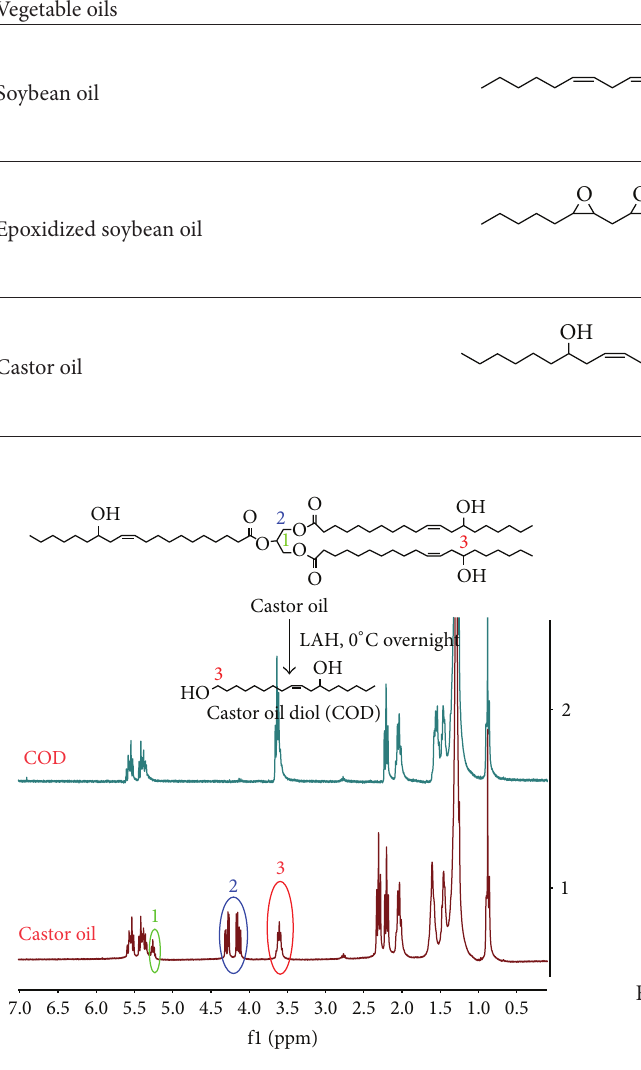
Figure 3: 1 H-NMR spectrum of castor oil and COD.